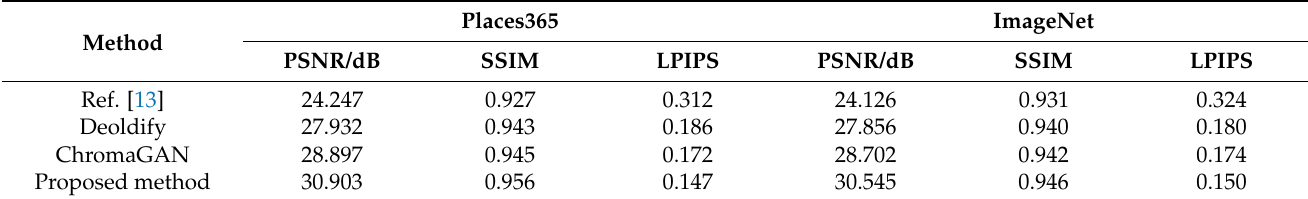
Table 3. Quantitative evaluation of the coloring results.